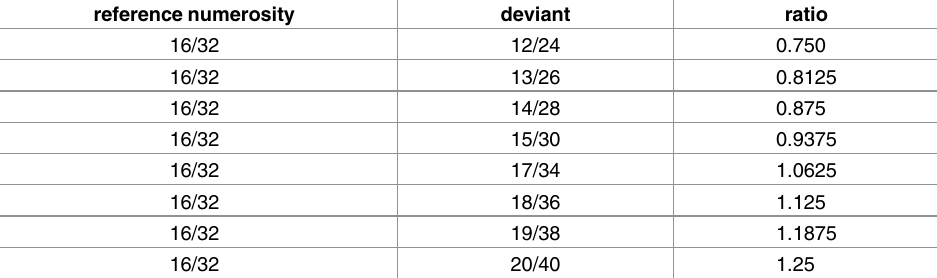
Table 1. Comparison pairs in the non-symbolic numerical magnitude comparison task. Each of the 16 comparisonpairs containeda reference numerosity(either 16 or 32 dots) and a deviantnumerosity (either between12 and 20 or between24 and 40